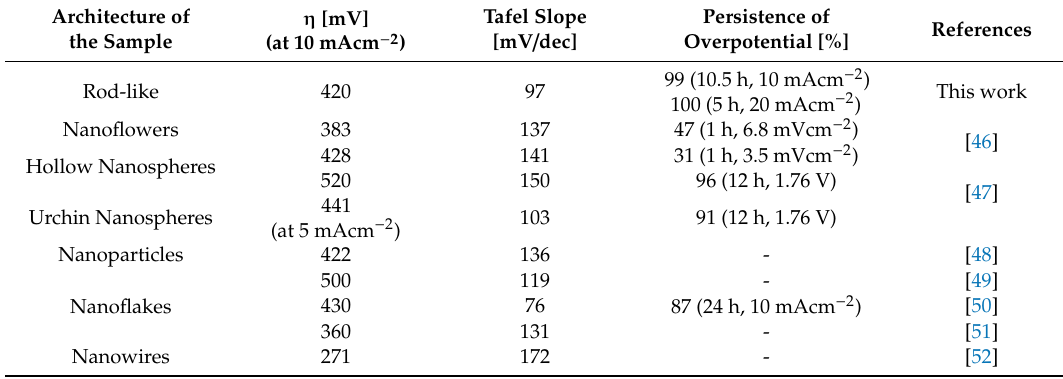
Table 2. Comparison of morphologies and catalysts activity exhibited by NiCo 2 O 4